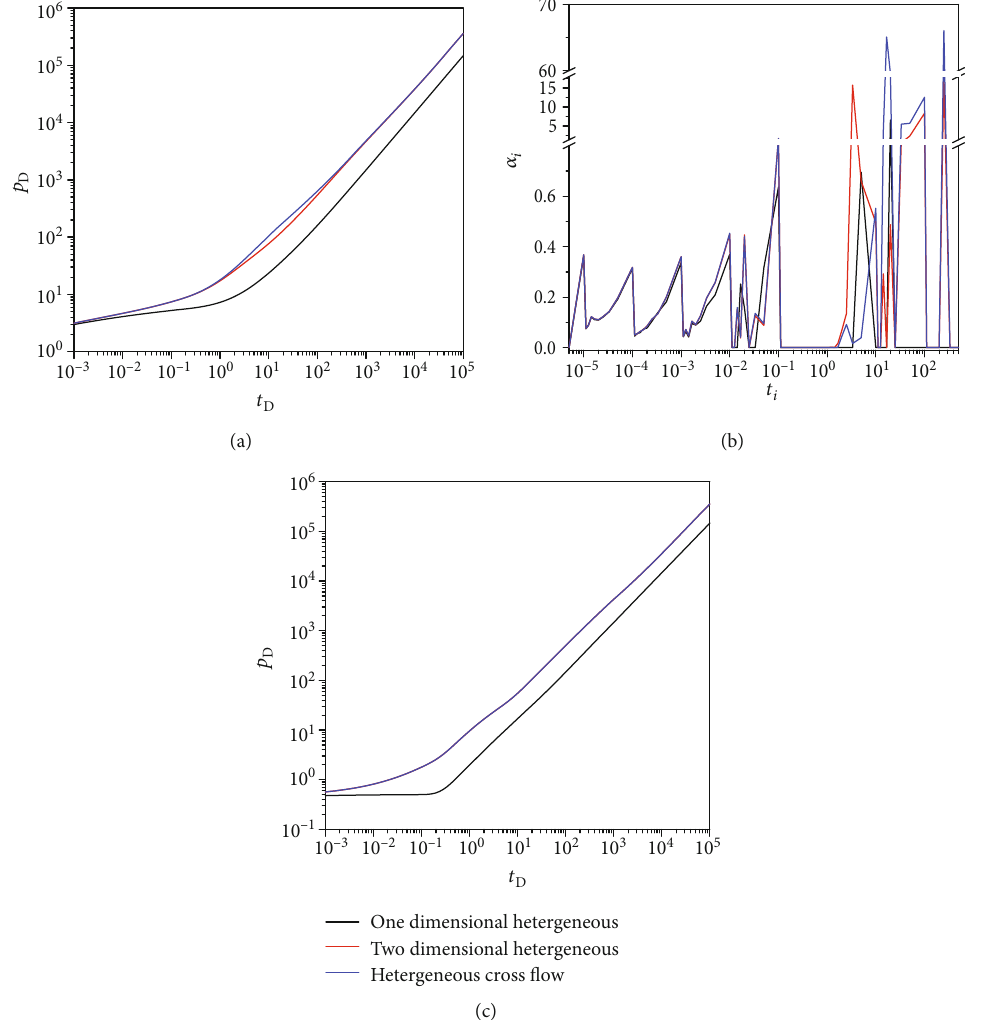
Figure 7: The wellbore dimensionless gas pressure at di ff erent heterogeneity conditions: (a) wellbore pressure, (b) temporal scale distribution, and (c) wellbore pressure